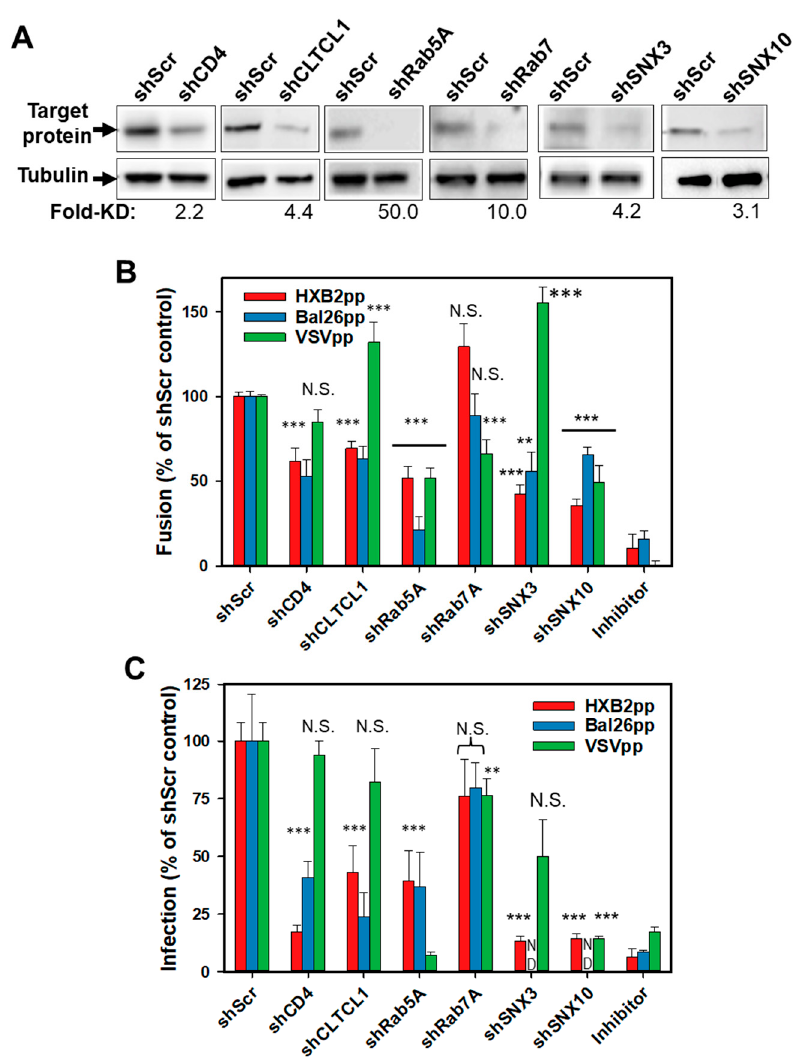
Figure 2. Validation of hits from the shRNA screen. ( A ) Western blot analysis of protein expression levels in control cells (shScr) and cells transduced with indicated shRNAs. Tubulin bands are loading controls. Fold-decrease in the protein expression level in shRNA-transduced cells relative to control cells determined by densitometry analysis is shown below the image panels. ( B ) Fusion activity of HXB2pp, BaL26pp and VSVpp in CEM.CCR5.shRNA cells relative to CEM.CCR5.shScr control cells. ( C ) Infectivity of HXB2pp, BaL26pp and VSVpp shRNA-transduced cells relative to control cells. As negative controls, HIV-1pp or VSVpp fusion experiments were carried out in the presence of 1 µM C52L peptide or 30 mM NH 4 Cl, respectively. For shCD4, shCLTCL1, shRab5A and shRab7A the data points in B and C are means and SD from three independent experiments performed in triplicate. For shSNX3 and shSNX10 the data points in B and C are means and SD from two independent triplicate experiments. **, P < 0.01; ***, P < 0.001; NS, not significant.